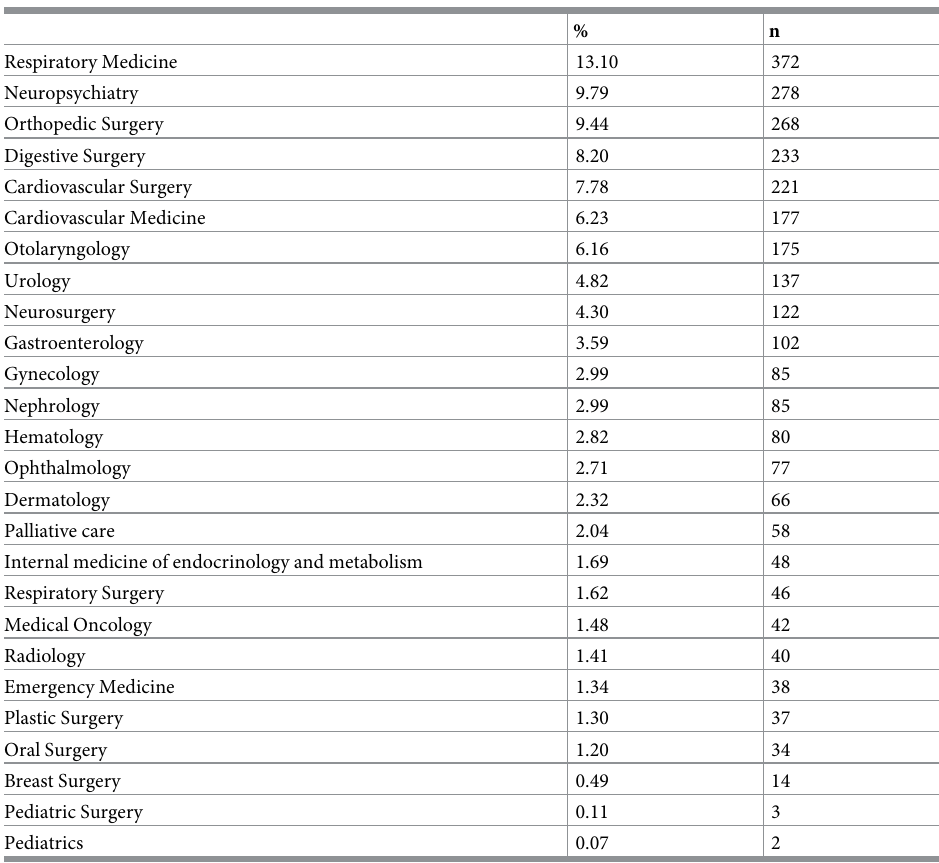
Table 1. Prevalence by